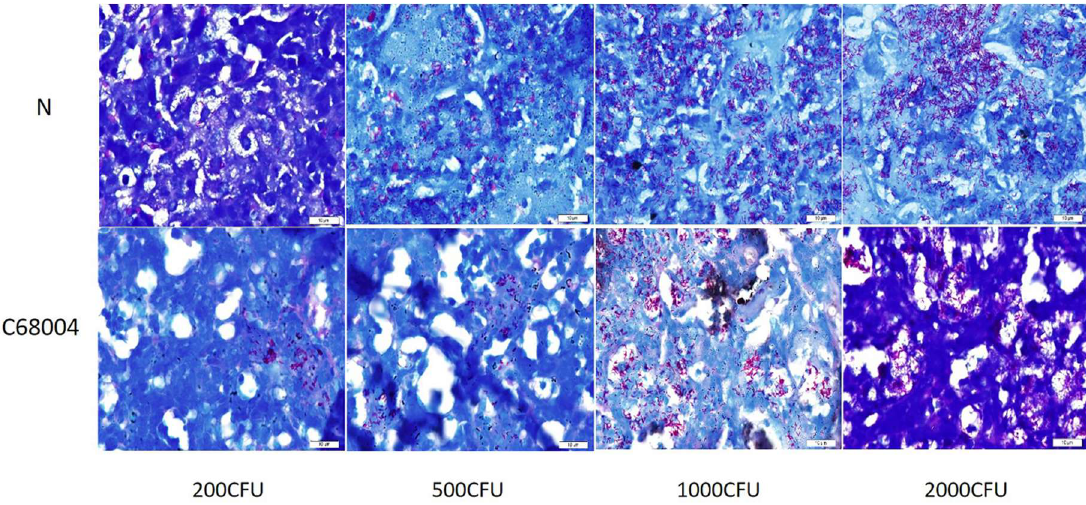
Figure 5. Acid fast bacilli in infected lung. High magnification of central necrotic areas showing M. bovis bacilli within cellular debris of infected lung. Scale bar: 10 μm.